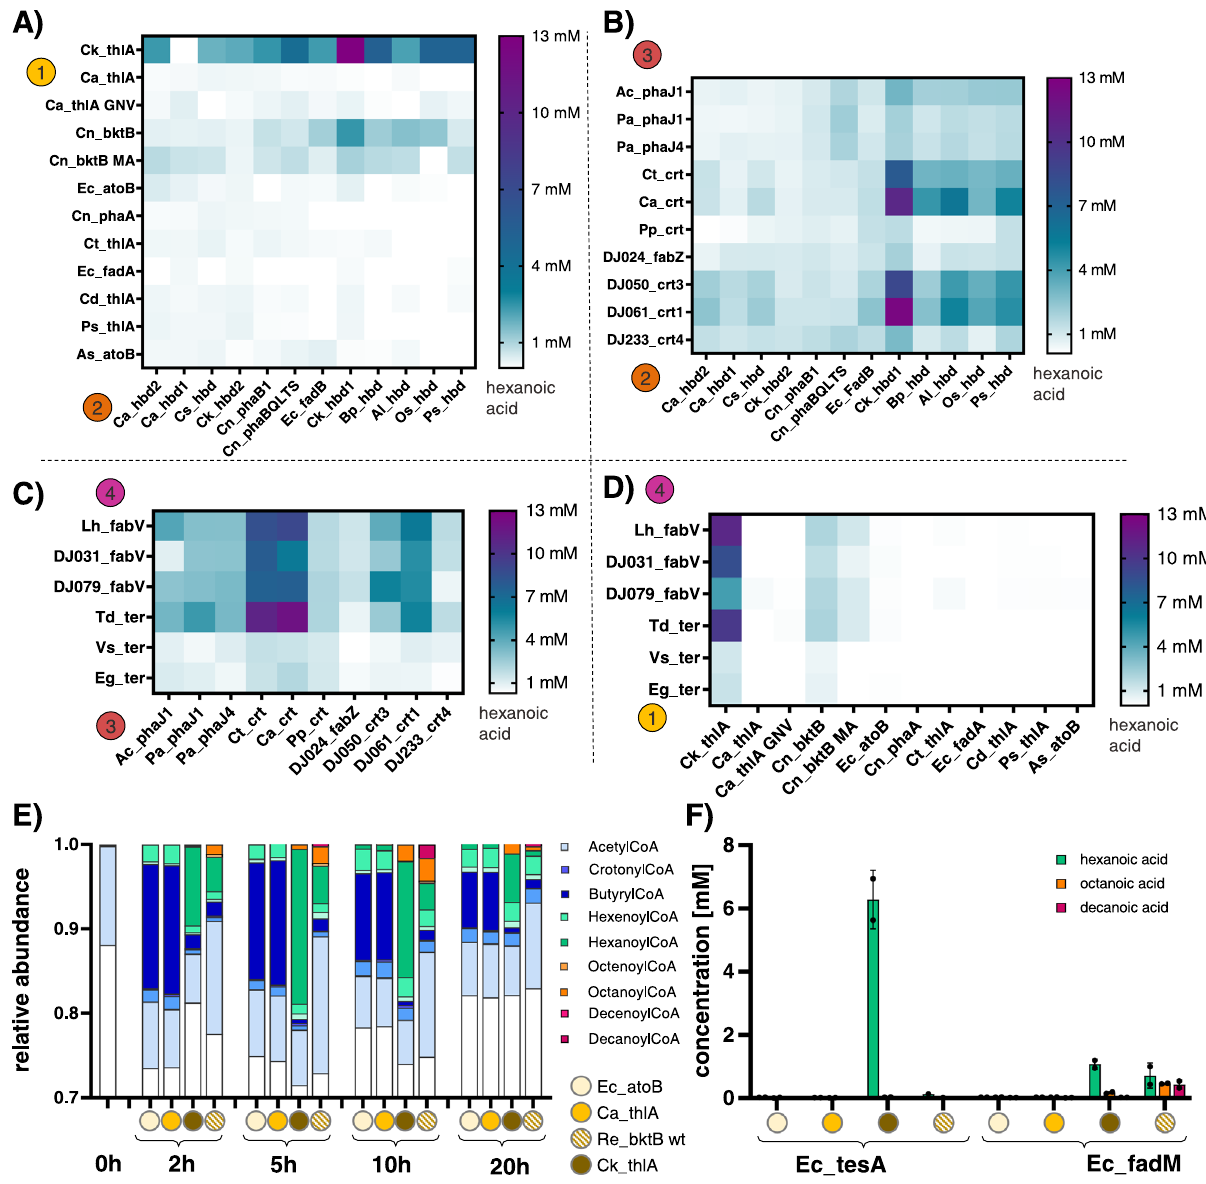
Fig. 2 Combinatorial screen of r-BOX enzyme homologs. All r-BOX enzymes were used at 0.3 μ M with 0.15 μ M of Ec_tesA and incubated at 30 °C for 24 h. n = 3, error bars = not shown (see Source Data fi le for complete data and enzyme abbreviations). The enzymes kept constant during the assay are Ck_thlA, Ck_hbd1, Ca_crt, Td_ter and Ec_tesA if they are not the ones investigated in the panel. A TL × HBD. B HBD × CRT. C CRT × TER. D TER × TL. Full results in Supplementary sheet 1. E Time-course SAMDI-CoA experiment showing dynamics of r-BOX assays over time. Maximum build-up of decanoyl- CoA occurs at 10 h using Re_bktB as the thiolase. All conditions were run and measured in quadruplicate and the average is displayed. F